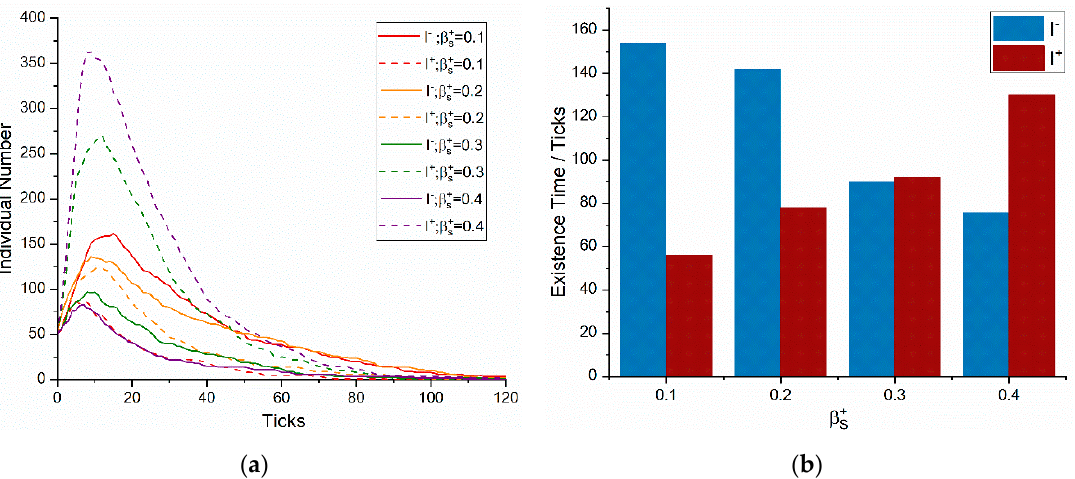
Figure 4 . OWOM communication effect when the positive OWOM acceptance index is different. (a) Figure 4. OWOM communication e ff ect when the positive OWOM acceptance index is di ff erent. The individual number of brand advocators and protesters; (b) the existence time of positive and ( a ) The individual number of brand advocators and protesters; ( b ) the existence time of positive and negative OWOM. negative OWOM.